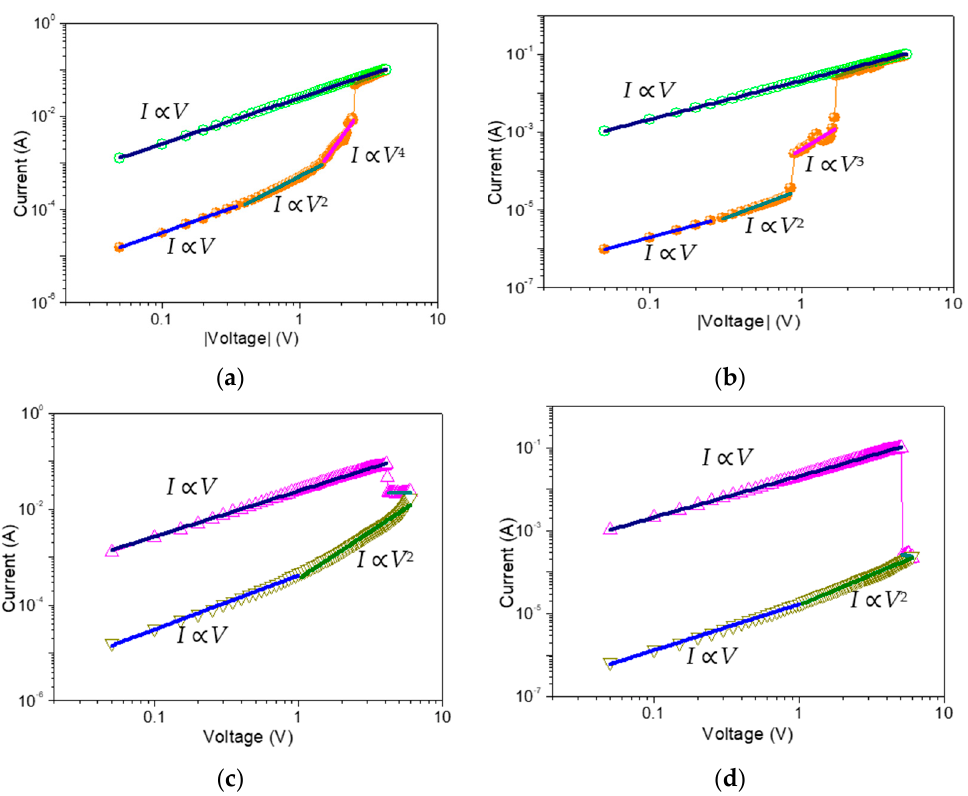
Figure 11. Double-logarithmic plots for ( a , b ) set and ( c , d ) reset process with the space-charge-limited model fitting for ITO /GO/ Ni and ITO /GO:0.5 wt%GQDs/ Ni, respectively.